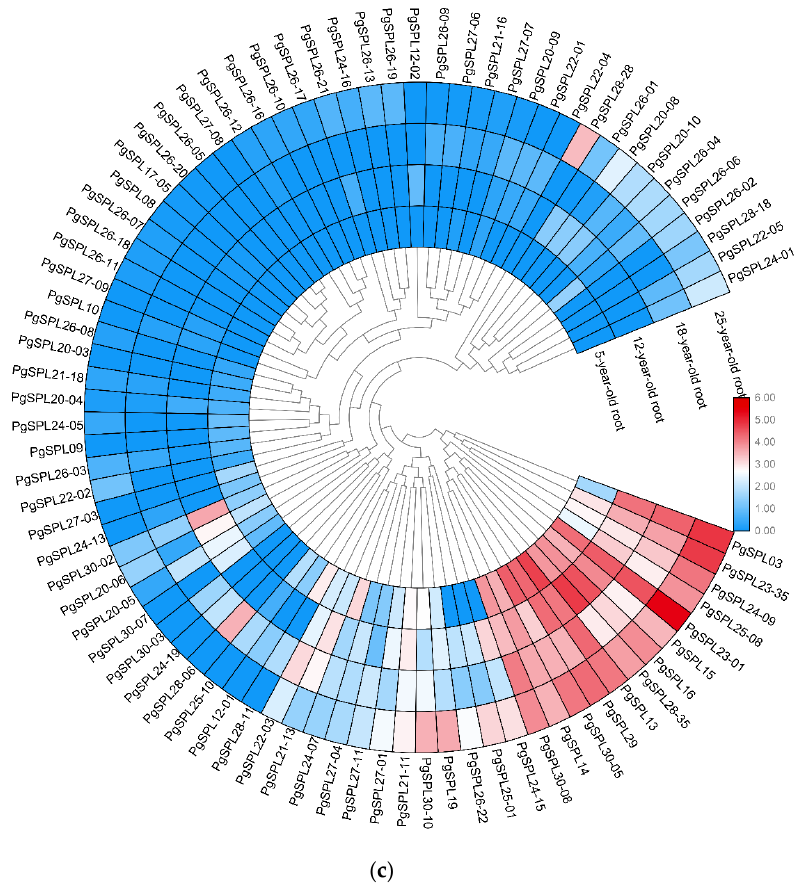
Figure 8. Expression heatmaps of the PgSPL gene family transcripts in Jilin ginseng. ( a ) The 106 PgSPL transcripts expressed in the 14 tissue of 4 years old ginseng. ( b ) The 106 PgSPL transcripts expressed in the 42 genotypes of 4 years old ginseng. ( c ) The 106 PgSPL transcripts expressed in the four different years old ginseng.